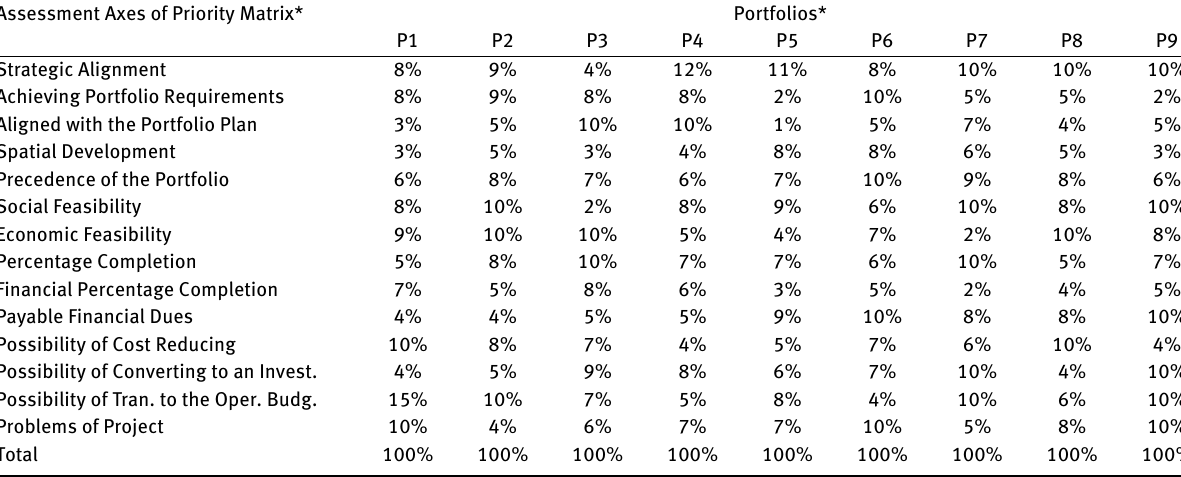
Table 9: Priority Matrix Assessment for Portfolios Assessment Axes of Priority